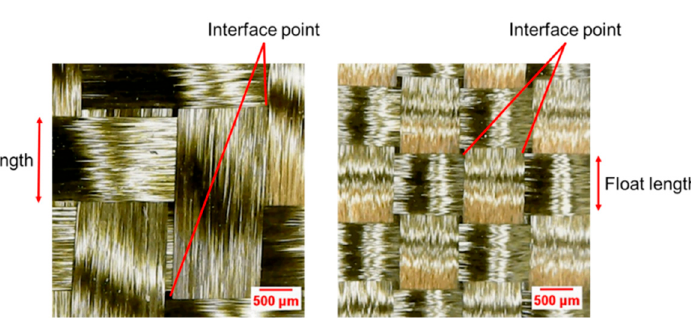
Figure 3. Twill ( left ) and plain ( right ) weave structures.